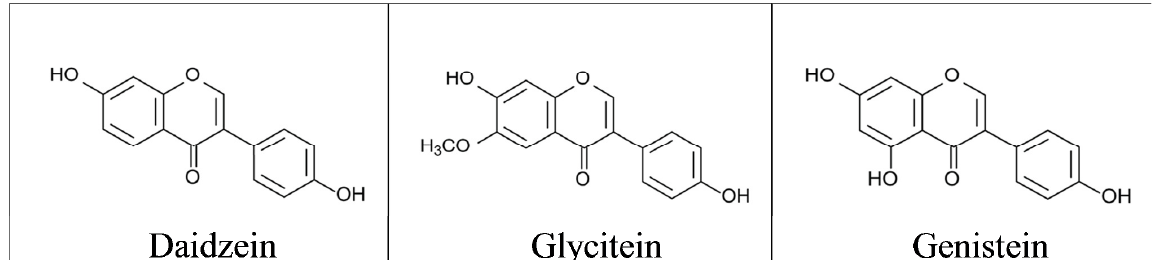
Fig. 1. Chemical structure of major aglycones IF; Daidzein (DI), Glycitein (GY) and Genistein (GN)